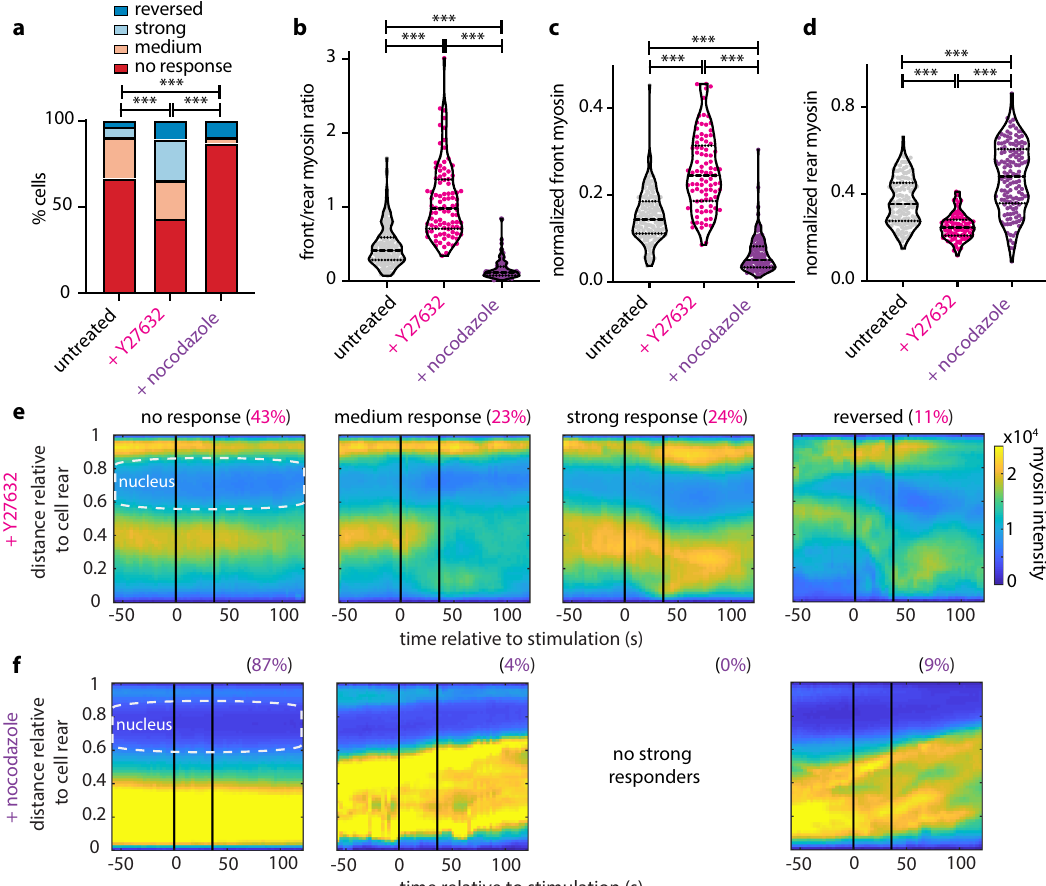
Fig. 7 Perturbations affecting myosin phosphorylation state alter the intracellular localization of myosin II and tune the sensitivity of the cell rear. a Stacked bar plots of the percentage of cells exposed to transient stimulation that showed no response, medium response, strong response, and reversed for n = 147 untreated cells, for n = 93 Y27632-treated, and n = 137 nocodazole-treated cells (from 8, 10, and 8 independent experiments, respectively); p - values of two-sided Fisher ’ s exact tests (*** p < 0.001). b – d Violin plots of mean front/rear myosin ratio ( b ), normalized front myosin ( c ), and normalized rear myosin ( d ) averaging over 15 s prior to stimulation for the same conditions and cells shown in a ; p -values of two-sided Wilcoxon ’ s rank-sum test (*** p < 0.001). e , f Average kymograph representation of myosin intensity as a function of time ( x -axis) and vertical position relative to the cell rear ( y - axis) for cells treated with Y27632 ( n = 93) ( e ) and nocodazole ( n = 137) ( f ). Vertical black lines indicate the start and stop of the pulsated stimulation. Source data are provided as a Source Data fi le, including exact p